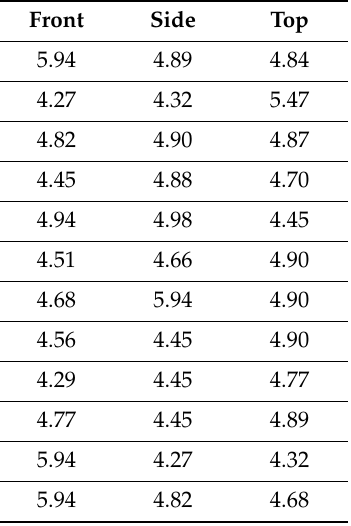
Table 23. DOE setup for percentage elongation as a function of build orientations.